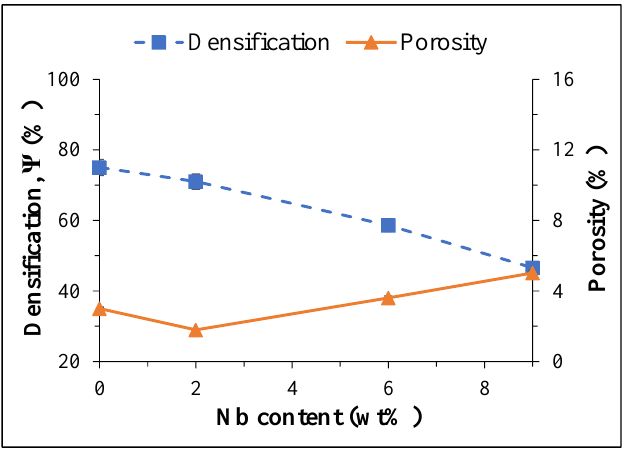
Figure 2. Relationship between densification and porosity as a function of the Nb content. Ti-5Fe data from ref. [37].